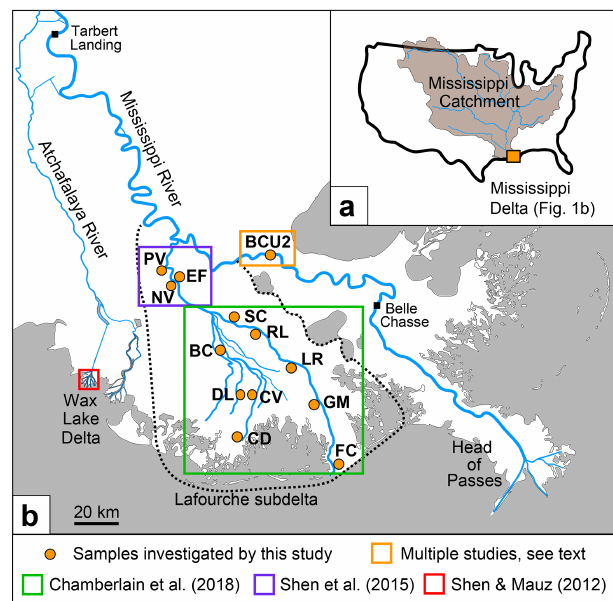
Figure 1. The Mississippi Delta and catchment (a) and locations of contemporary Mississippi River and Lafourche subdelta sam- ples used for this study and their primary references, plus the lo- cations of previous research in the Wax Lake Delta and of river gauge stations (b) . See Sect. 3.1 for the primary references of the modern river samples (orange box). Modified from Chamberlain et al.